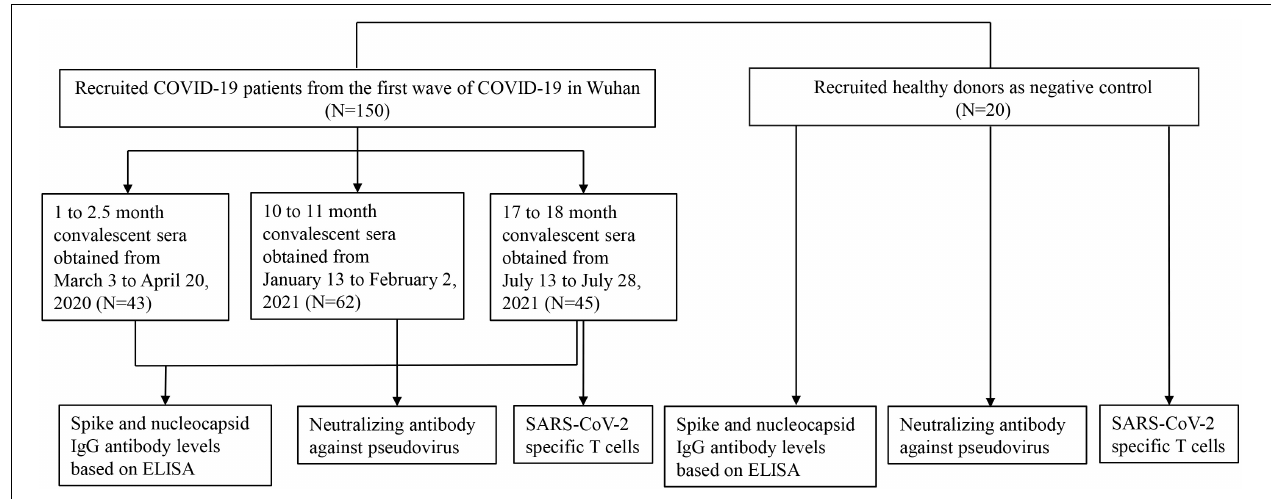
FIGURE 1 | Enrollment of COVID-19 patients and healthy persons. A total of 150 COVID-19 patients including inpatients and convalescent patients were enrolled in this study and patients’ sera were obtained from 1 to 18 months after the onset of illness in three periods (1–2.5, 10–11, and 17–18 months). A total of 20 healthy persons were recruited as the negative